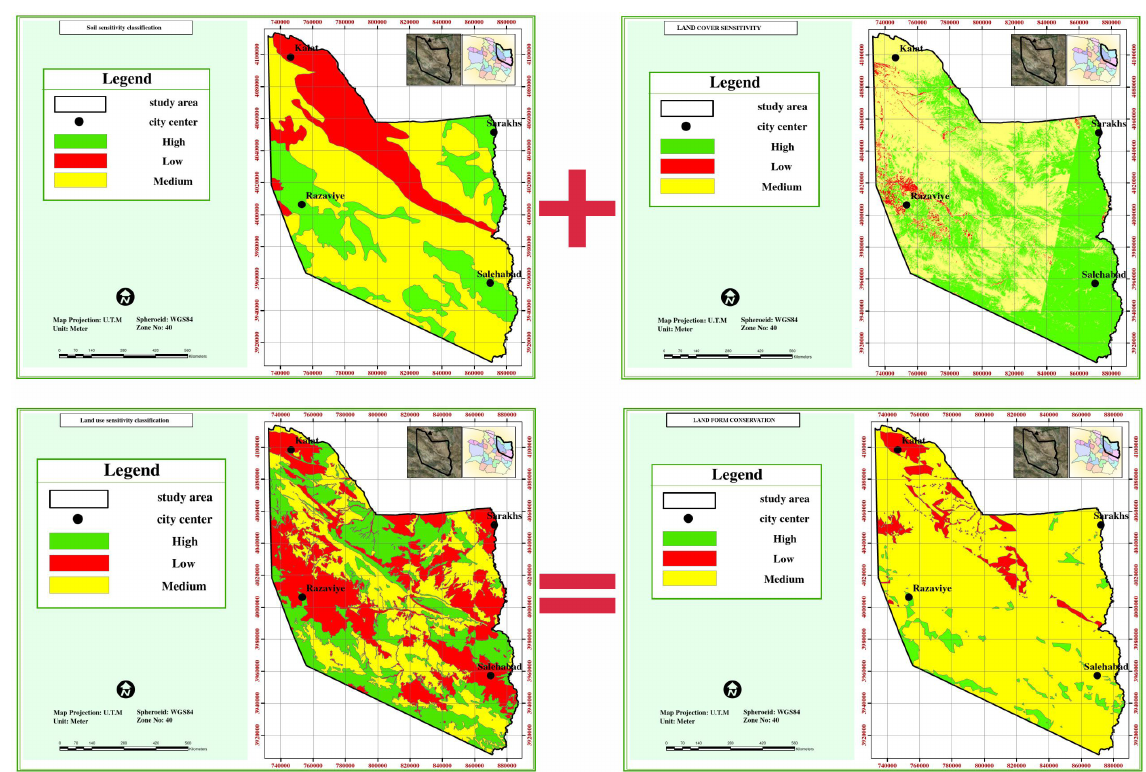
Figure 6. Overlay of the sub-criteria maps used in the preparation of conservation maps